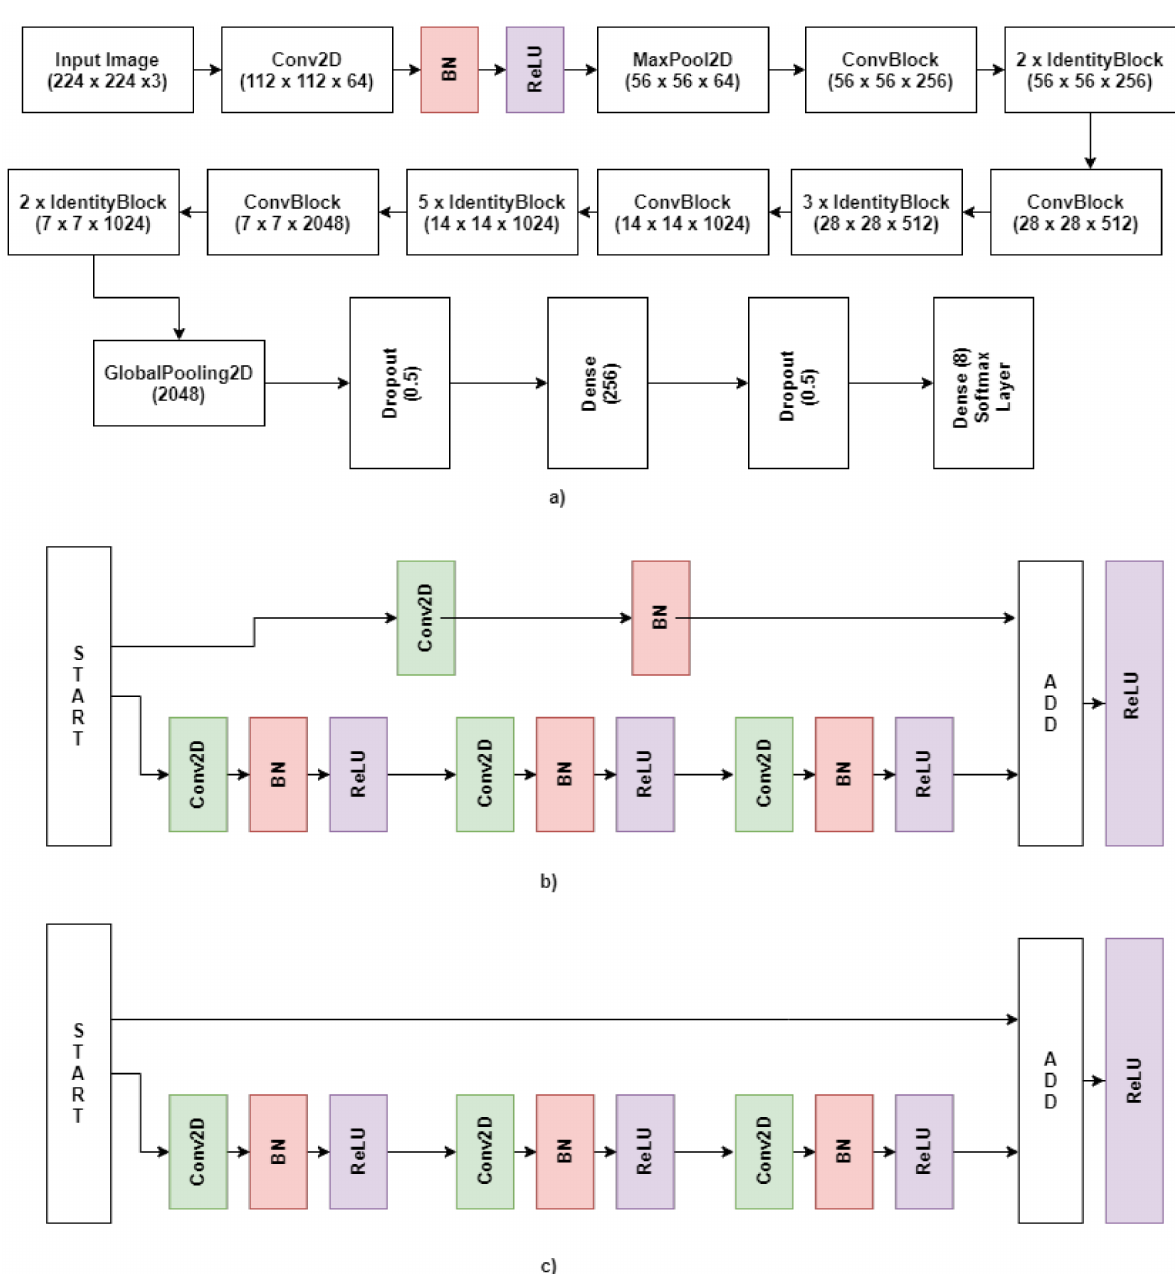
Figure 6. Model architecture containing Covolutional and identity block and placed after. ( a ) Complete Architecture; ( b ) ConvBlock used in Figure 6a; ( c ) IdentityBlock used in Figure 6a. ConvBlock is similar to Identity Block as both pave the way for residual learning for the network, the only difference being that ConvBlock is used when the input and output dimensions donot match. Figure 7 shows the global average 2D pooling